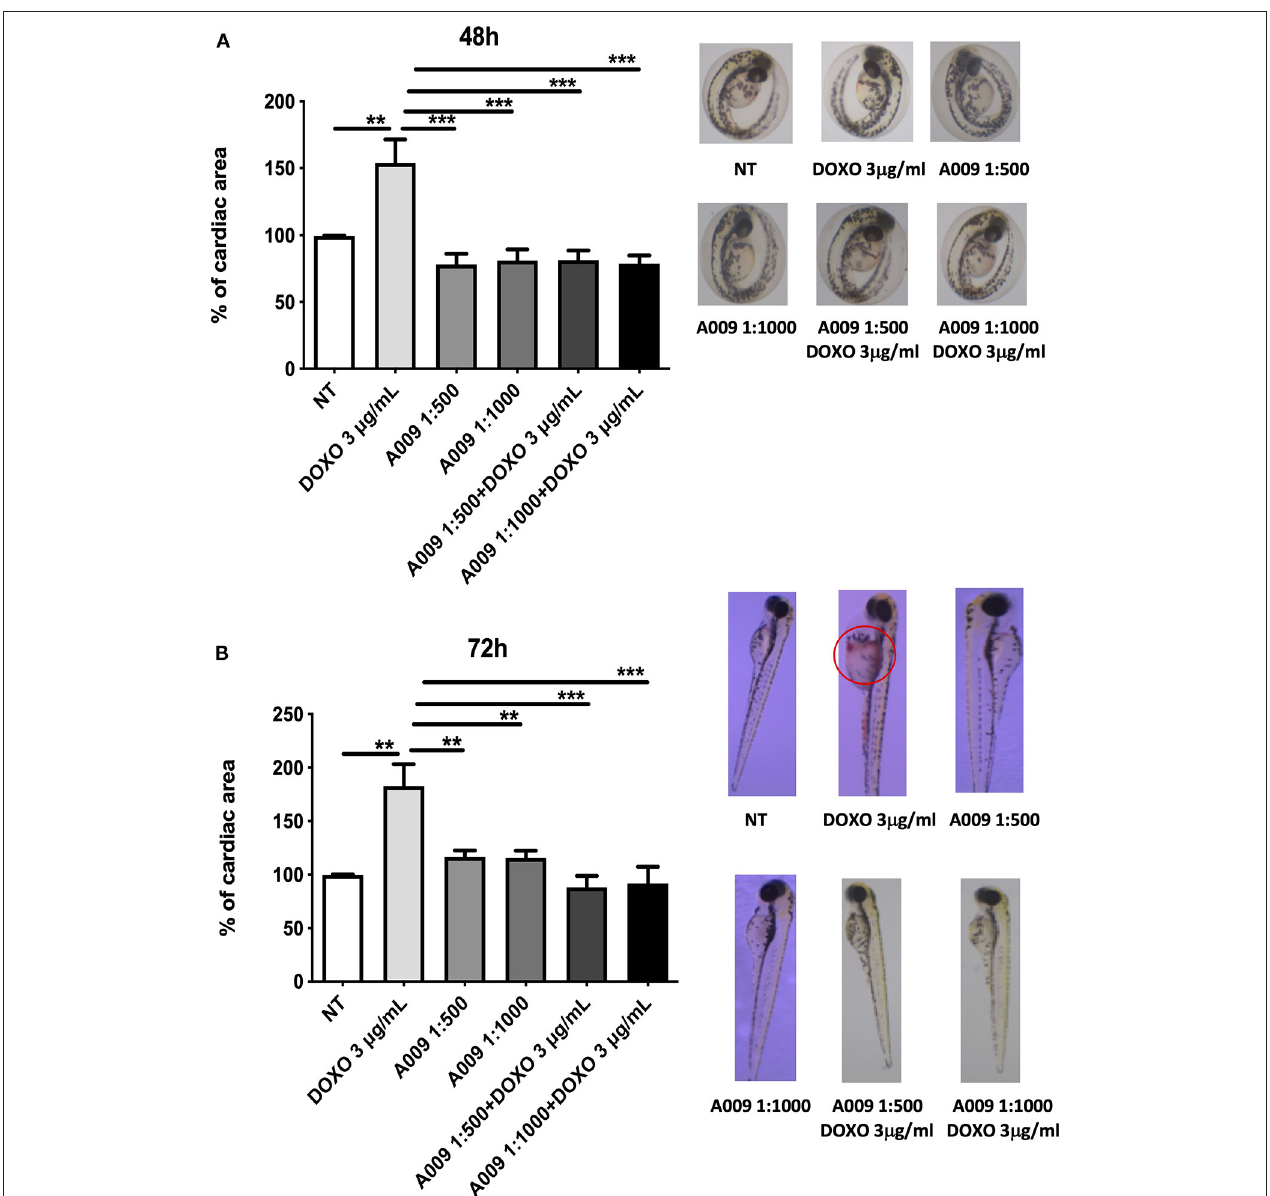
FIGURE 7 | Cardioprotective effects of A009 extract in zebrafish embryos. The cardioprotective effects of the A009 extract on chemotherapy-induced cardiotoxicity was investigated in zebrafish embryos. All experiments were performed on zebrafish embryos exposed to doxorubicin (3 µ g/ml) alone, A009 (dilution 1:1,000, 1:500), or the combination of doxorubicin ( µ g/ml) and A009 (dilution 1:1,000, 1:500) for 48h (A) and 72h (B) post fertilization (hpf). Embryo micrographs for all the experimental conditions are shown. Data for cardiac area are shown as fold% increased over control. Data are shown as mean and *** p < 0.001. DOX, doxorubicin; A009 batch extract; NT, not treated. A009 combinations with chemotherapy were protective toward the